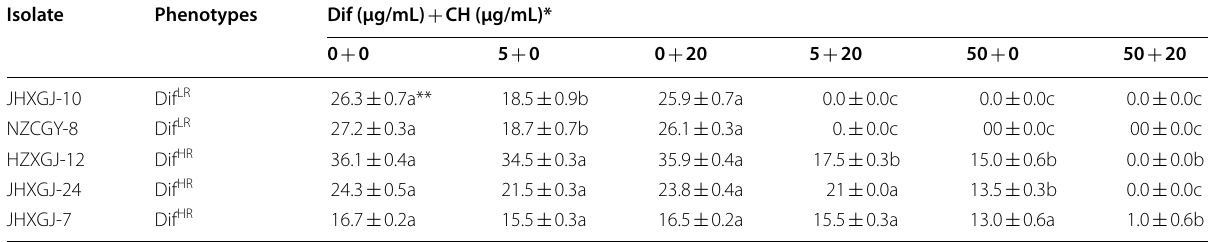
*Chlorpromazine hydrochloride (CH), difenoconazole (Dif). Dif LR , difenoconazole low-level resistant isolate; Dif HR , difenoconazole high-level resistant isolate. **Data were colony diameter (mm) provided as mean SD, mean values in the same line with the same letters were not statistically different ( P > 0.05) according to the least ± significant difference (LSD) test